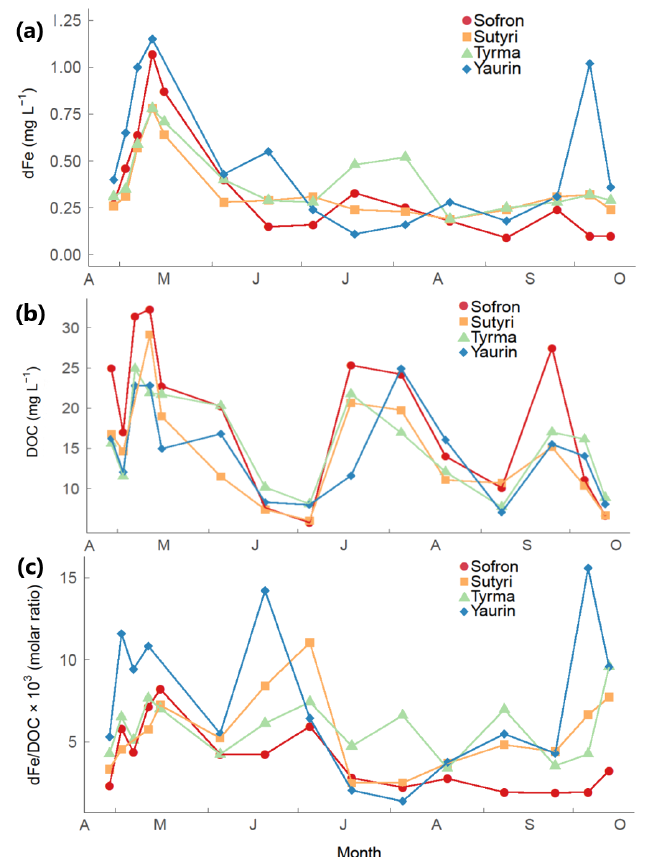
Figure 4. Seasonal changes in dFe and DOC concentrations in the Sofron River and the large rivers (Sturi, Tyrma, and Yaurin) [( a ) dFe concentration; ( b ) DOC concentration; ( c ) dFe/DOC molar